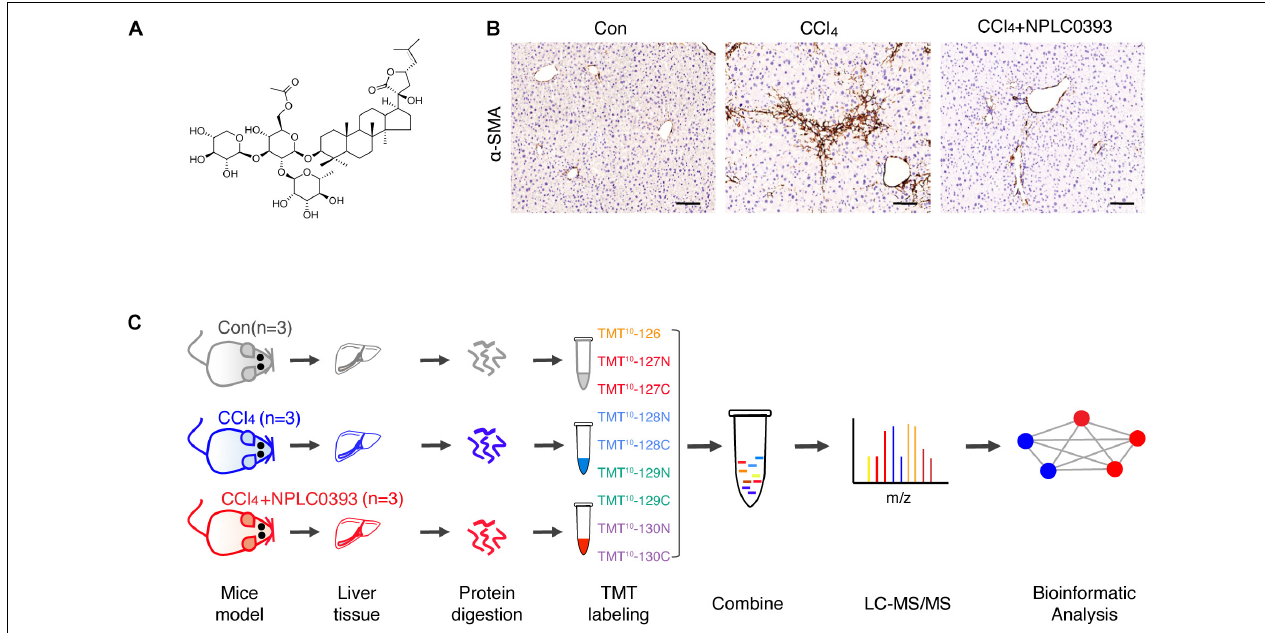
FIGURE 1 | Quantitative proteomic analysis of mice liver tissue from different treatment groups. (A) Chemical structure of NPLC0393. (B) Liver sections from mice in the control (Con), CCl 4 model (CCl 4 ), and CCl 4 model combined with NPLC0393 treatment (CCl 4 + NPLC0393) groups were immunohistochemically stained with an anti- α -SMA antibody (scale bar, 100 µ m). (C) Schematic of the experimental